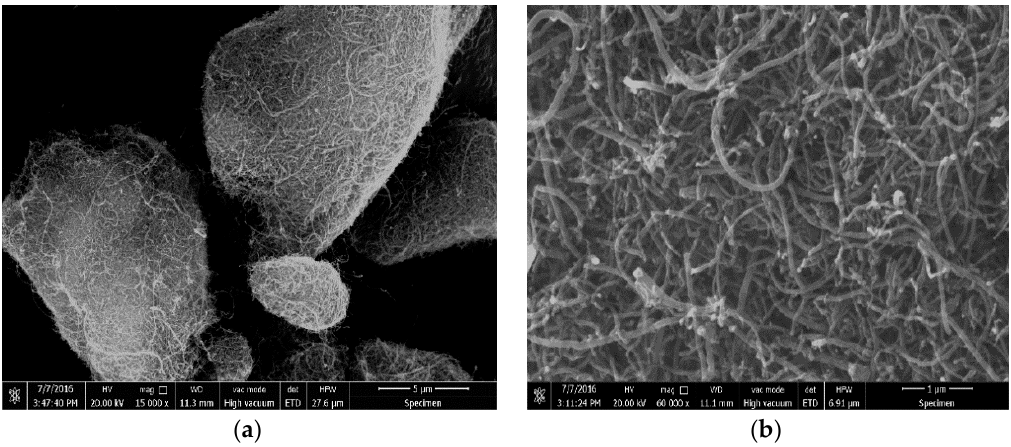
Figure 2. SEM images of hydroxyl functionalized multi-walled carbon nanotubes (MWCNTs–OH) under different magnification. ( a ) 15,000×; ( b ) 60,000×.